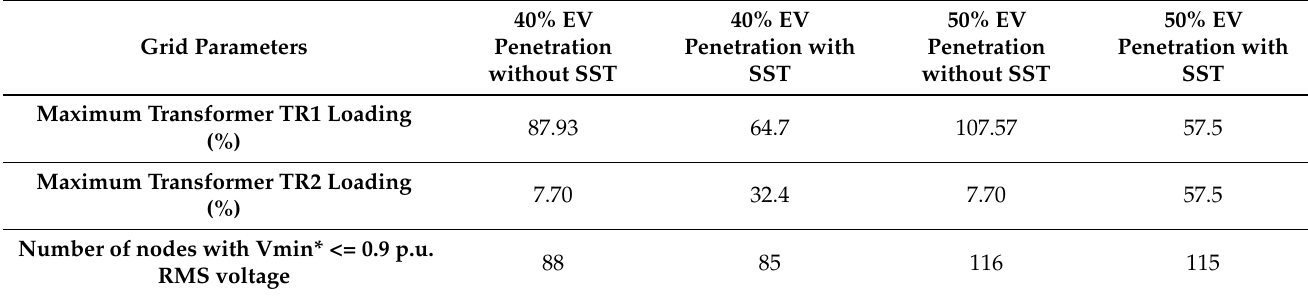
Table 3. Comparison of grid parameters for different loading conditions and SST configurations.